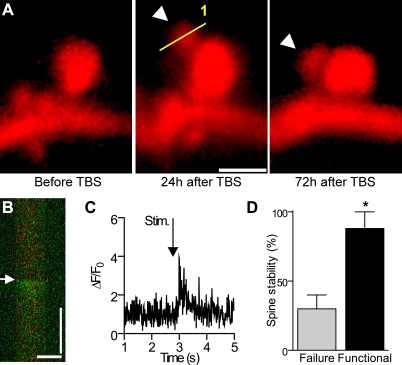
Functional Properties of Newly Formed Spines(A) Newly formed spine detected 24 h after application of TBS (line scan; scale bar: 1.5 μm) and still present 48 h later (arrowhead).(B) Line scan showing, superimposed, the mRFP and Fluo-4 channels obtained by analysis of the new spine illustrated in (A) and activated by electrical stimulation (arrow) 24 h after TBS (scale bars: 1 μm; 1 s).(C) Fluo-4 signal recorded in (B) following electrical stimulation (arrowhead) and expressed as ΔF/F0.(D) Stability of newly formed spines that responded by a calcium signal upon stimulation (functional, black column) or failed to respond (failure, grey column) and measured over 48 h later (n = 5 cells; *p < 0.05, Mann-Whitney U-test).